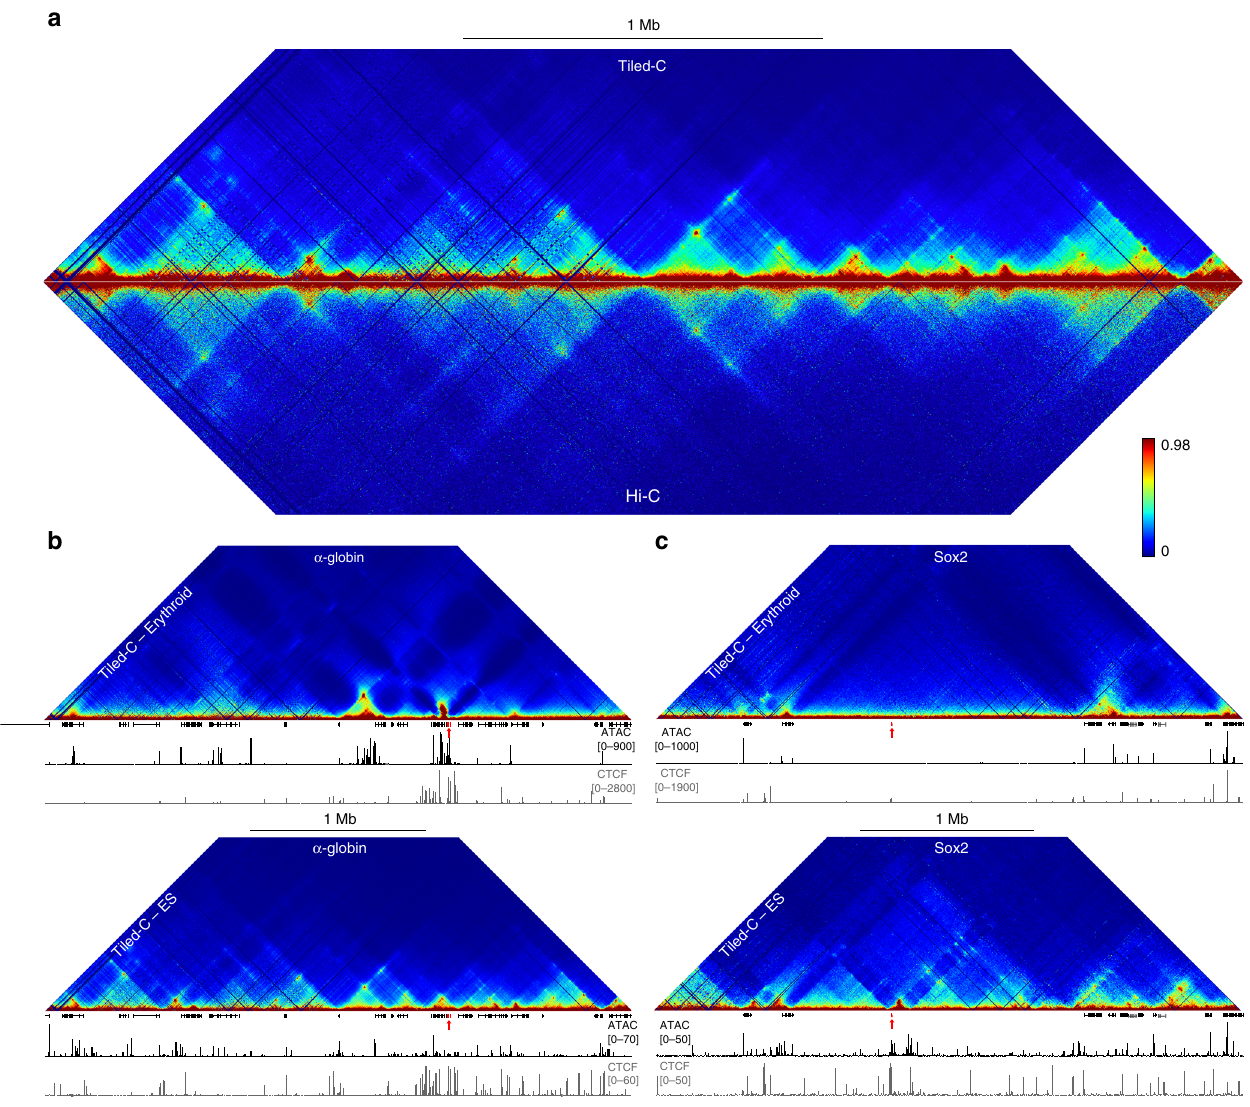
Fig. 1 Tiled-C generates deep all vs all 3C data at regions of interest. a Comparison of Tiled-C and Hi-C contact matrices at 2 kb resolution in mouse ES cells. Contact frequencies represent normalized, unique interactions in three and four replicates for Tiled-C and Hi-C data, respectively. Coordinates (mm9): chr11:29,902,000 – 33,228,000. b Tiled-C contact matrices of ~3.3 Mb spanning the mouse α -globin locus in primary mature erythroid cells (top) and ES cells (bottom) at 2 kb resolution. Contact frequencies represent normalized, unique interactions in three replicates. Gene annotation ( α -globin genes highlighted in red), open chromatin (ATAC), and CTCF occupancy are shown below the matrices. Coordinates (mm9): chr11:29,902,000 – 33,228,000. c Tiled-C contact matrices of ~3.4 Mb spanning the mouse Sox2 locus in primary mature erythroid cells (top) and ES cells (bottom) at 5 kb resolution. Contact frequencies represent normalized, unique interactions in four replicates. Gene annotation ( Sox2 gene highlighted in red), open chromatin (ATAC), and CTCF occupancy are shown below the matrices. Coordinates (mm9): chr3:33,200,000 –